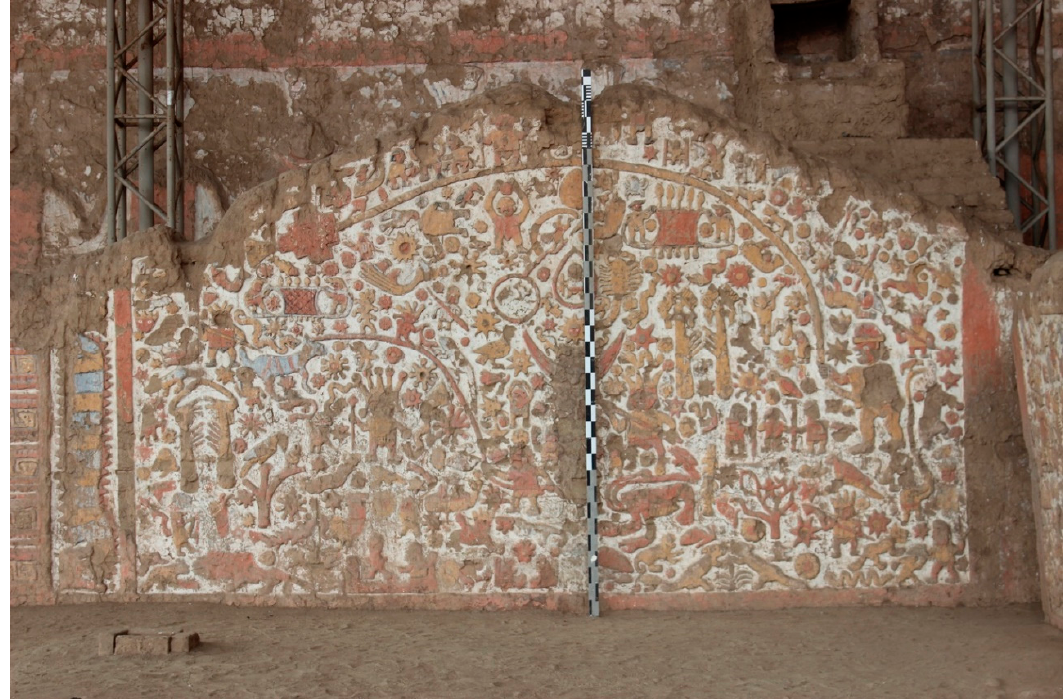
Figure 2. Mural of Complex Theme 1 at Huaca de la Luna (Courtesy of Luis Manuel González La Rosa).